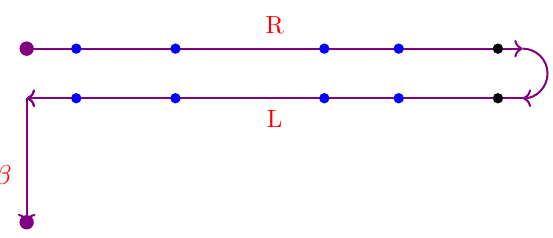
Figure 1 . An illustration of the hydrodynamic observables in the Schwinger-Keldysh functional integral phrased in the Keldysh average-di(cid:11)erence basis. Response functions are correlators of a sequence of di(cid:11)erence operators (the external disturbances, denoted as blue dots) followed by an average operator (the measurement, denoted by the black dots) in the